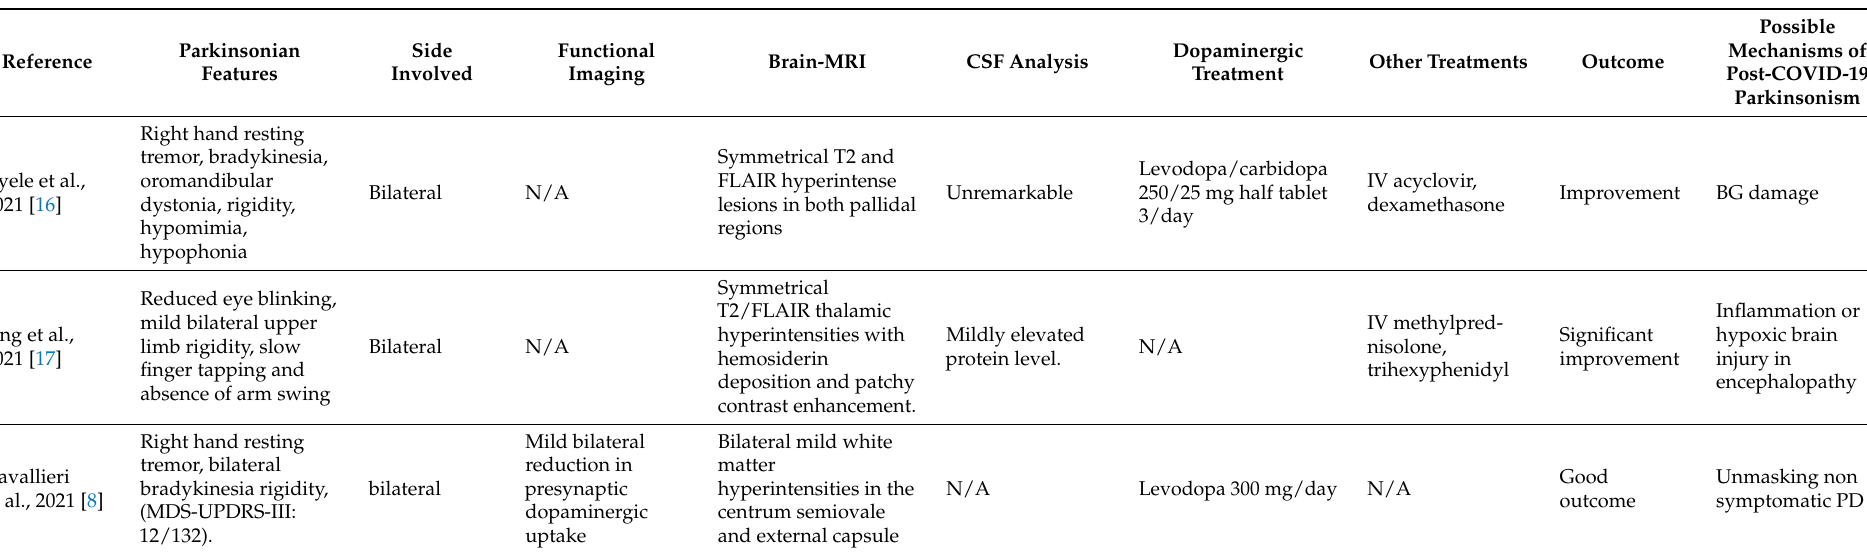
Table 2. Neuroimaging findings and treatment of the 13 patients included in the